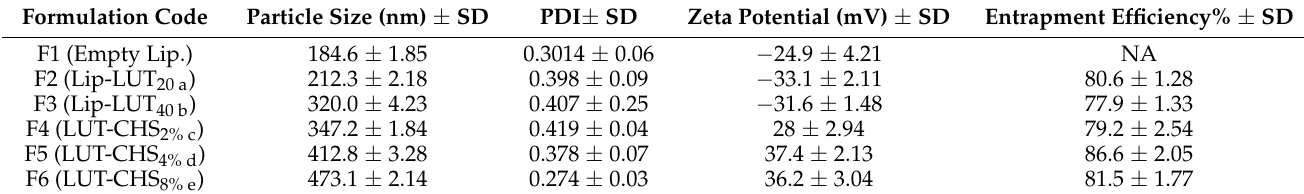
Table 2. Mean Particles Size, Polydispersity Index, Zeta Potential and entrapment efficiency of empty liposomes, luteolin loaded liposomes, empty chitosomes and Luteolin-loaded Chitosomes. Measurements are expressed as mean ±